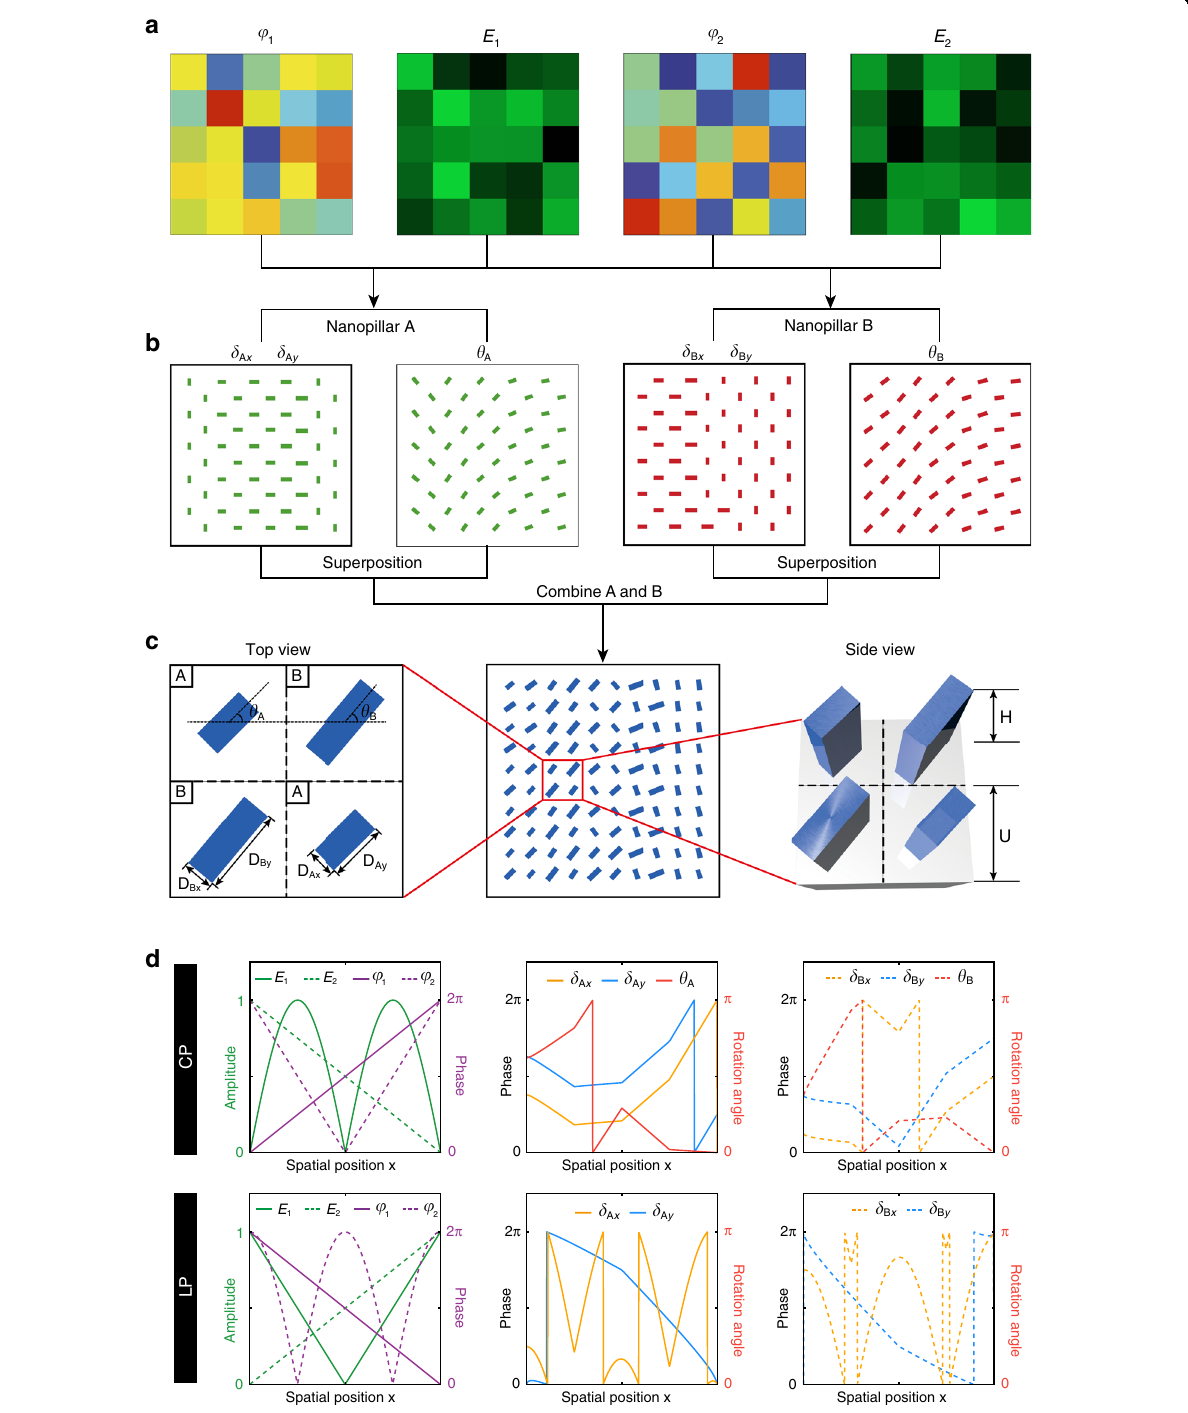
Fig. 2 Design principle of a multifunctional metasurface. a – c A general design fl ow of multifunctional metasurface for independent phase and amplitude control of orthogonal polarization states. a The target amplitude and phase pro fi les encoded on the metasurface. b The dimensions and orientation angles of nanopillars A and B are determined by the calculation results of δ Ax , δ Ay , θ A δ Bx , δ By , and θ B . c The fabricated multifunctional metasurface is composed of TiO 2 rectangular nanopillars with same height H . One superpixel of the metasurface consists of four nanostructures, two nanopillar A and two nanopillar B, which are alternately arranged on a fused-silica substrate in a square lattice U . d Top panel: for orthogonal circular polarizations and given arbitrary amplitude and phase distribution of E 1 = |sin x |, E 2 = 1 − x /2 π , φ 1 = x and φ 2 = |2 π − 2 x| (left), where x ∈ [0, 2 π ], the required phase shifts and orientation angles of the nanopillar A (middle) and nanopillar B (right) can be obtained. Bottom panel: for orthogonal linear polarizations and given arbitrary amplitude and phase distribution of E 1 = x / π − 1, E 2 = x /2 π , φ 1 = | x − 2 π | and φ 2 = |2 π cos x | (left), where x ∈ [0, 2 π ], the required phase shifts of the nanopillar A (middle) and nanopillar B (right) can be obtained,